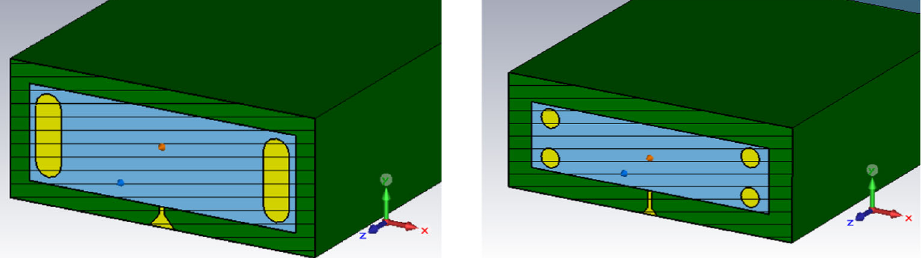
FIG. 5. Transverse section view of lumped kicker models used for CST simulations of PS kicker KFA28 (left) and BFA09S-21S (right). The kickers are made of a single ferrite yoke (in green). A brick of aluminium is inserted in the yoke in order to reduce the impedance seen by the beam. Kickers with the prefix KFA are designed with two conducting cables, while kickers with the prefix BFA are designed with four conducting cables, modeled in CST as aluminium (in yellow). Vacuum is represented in light blue.